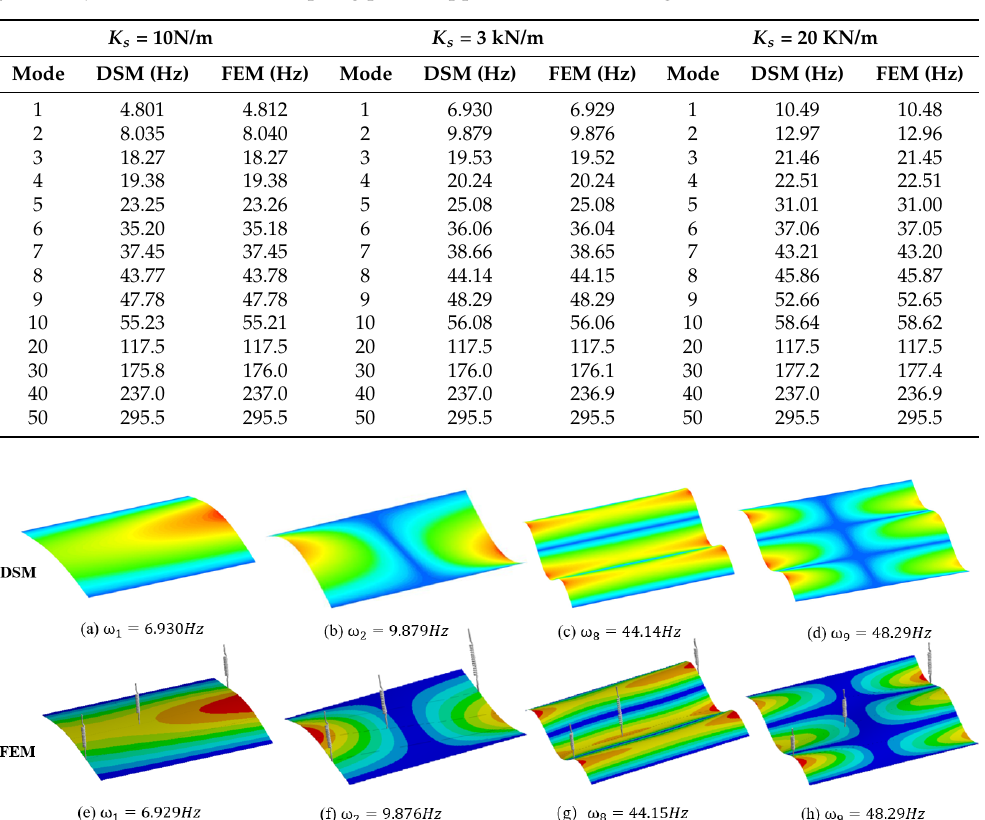
tabulated in Table 2. The 1st, 2nd, 8th and 9th natural mode shapes with K s = 3 kN/m computed by both DSM and FE package ANSYS are compared and contrasted in Figure 14. Table 2. The first 10 natural frequencies and the 20th, 30th, 40th and 50th natural frequencies for a plate subjected to three elastic spring point supports as shown in Figure 12.